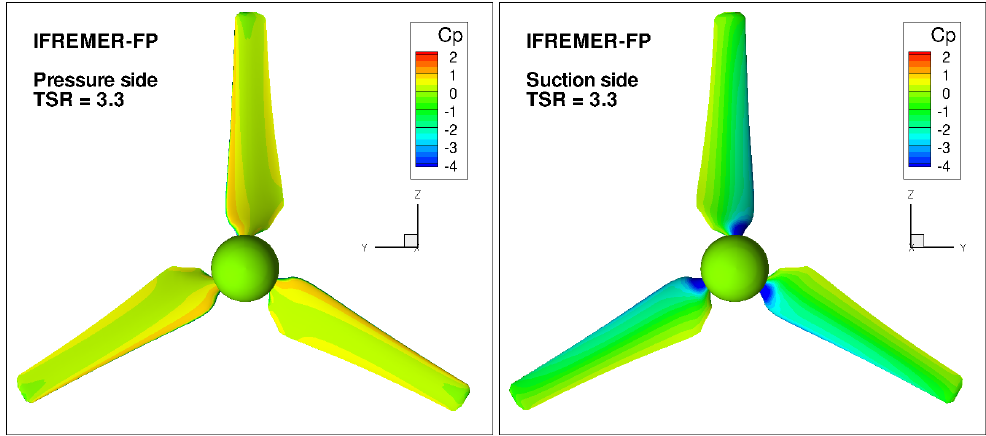
Figure 13. IFREMER-FP turbine. Pressure distribution evaluated by inviscid-flow BIEM, TSR = 3.3 (peak power condition). Left : pressure side; right : suction side.